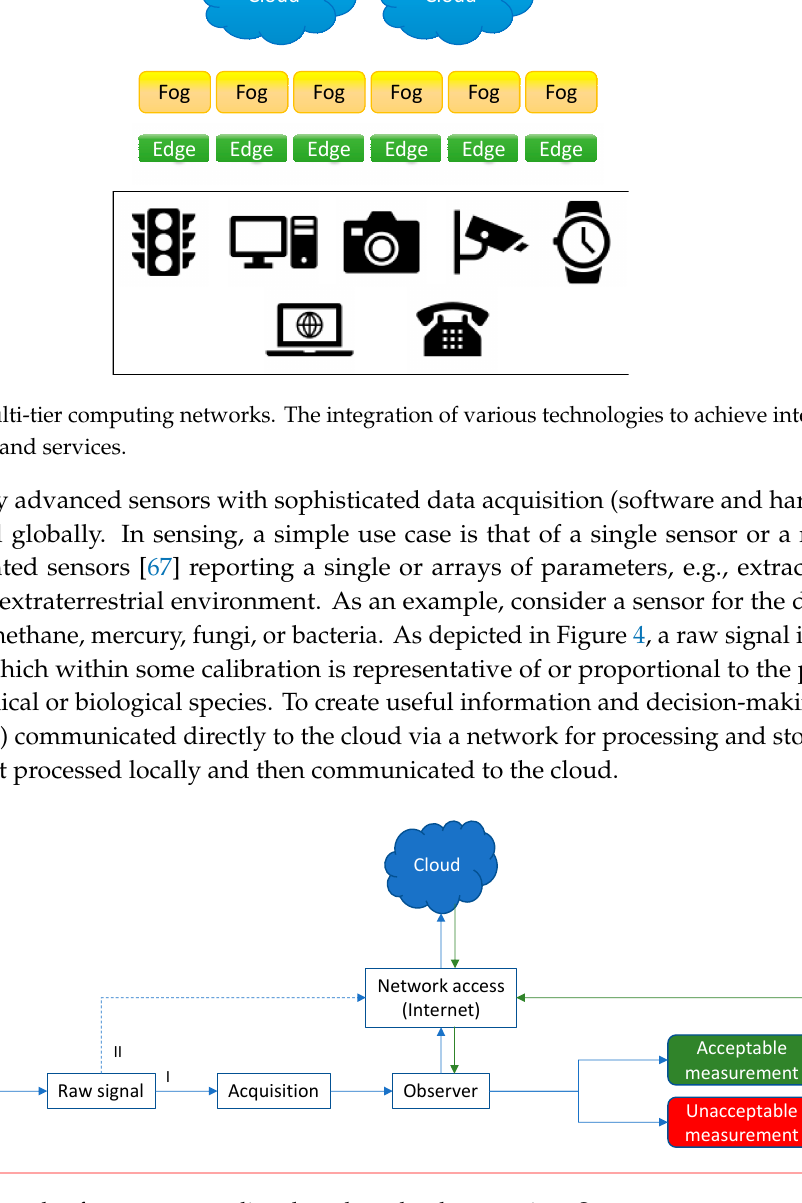
Figure 4. Example of a current paradigm based on cloud computing. Sensors generate raw signals, which are submitted to the cloud directly (route II) or are acquired and observed and then either communicated to the cloud or are evaluated and submitted to the cloud.